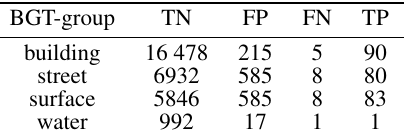
Table 4. Results for confusion matrix based on different groups